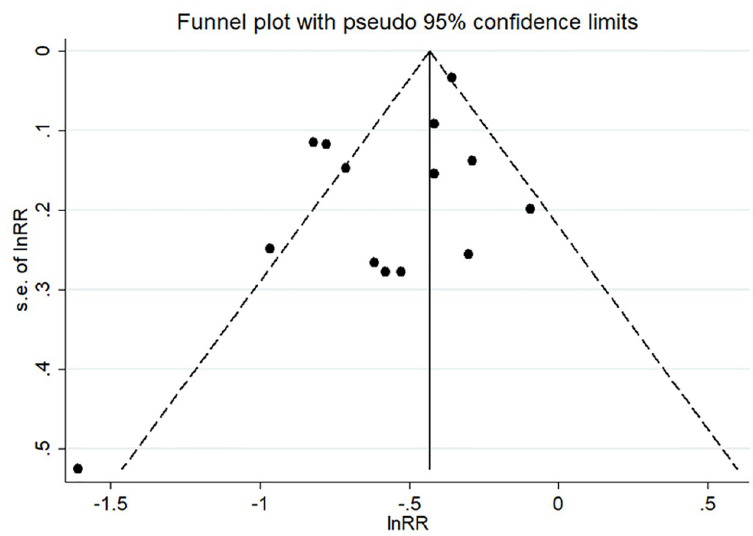
Fig 3. Funnel plots with pseudo 95% confidence limits for the association between physical activity and the risk of